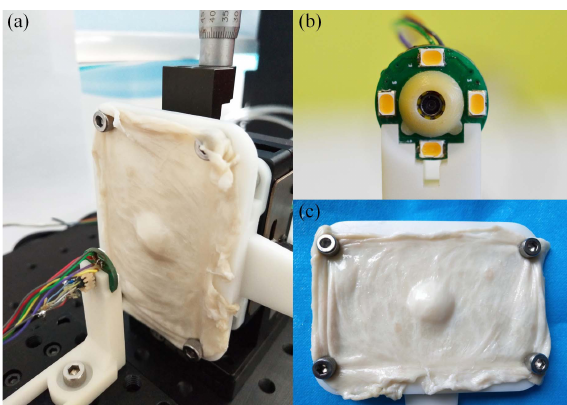
Figure 11. Test bench for the experiment. ( a ) General view of the test bench. ( b ) Front view of the monocular capsule endoscope. ( c ) Pig colon tissue fixed on the 3D printed base board. (Considering